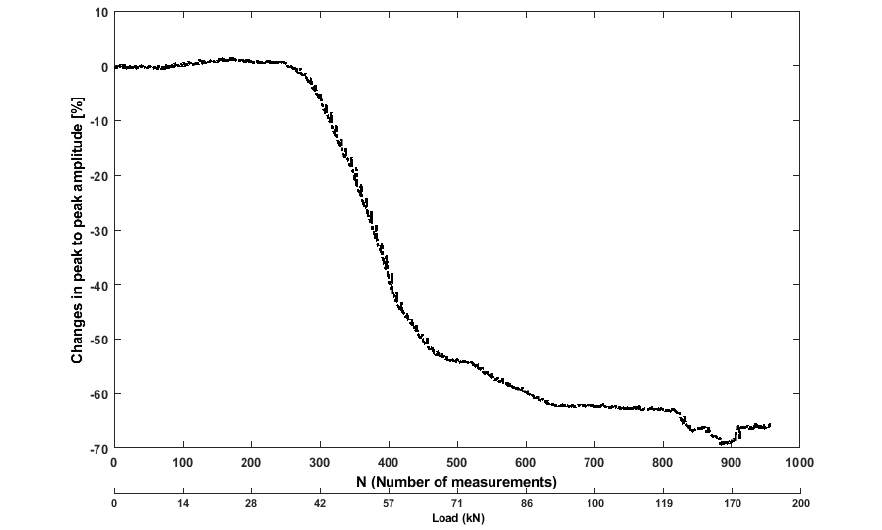
Figure 12. Values of Peak to peak amplitude feature from ultrasonic pair S01R04 time histories.